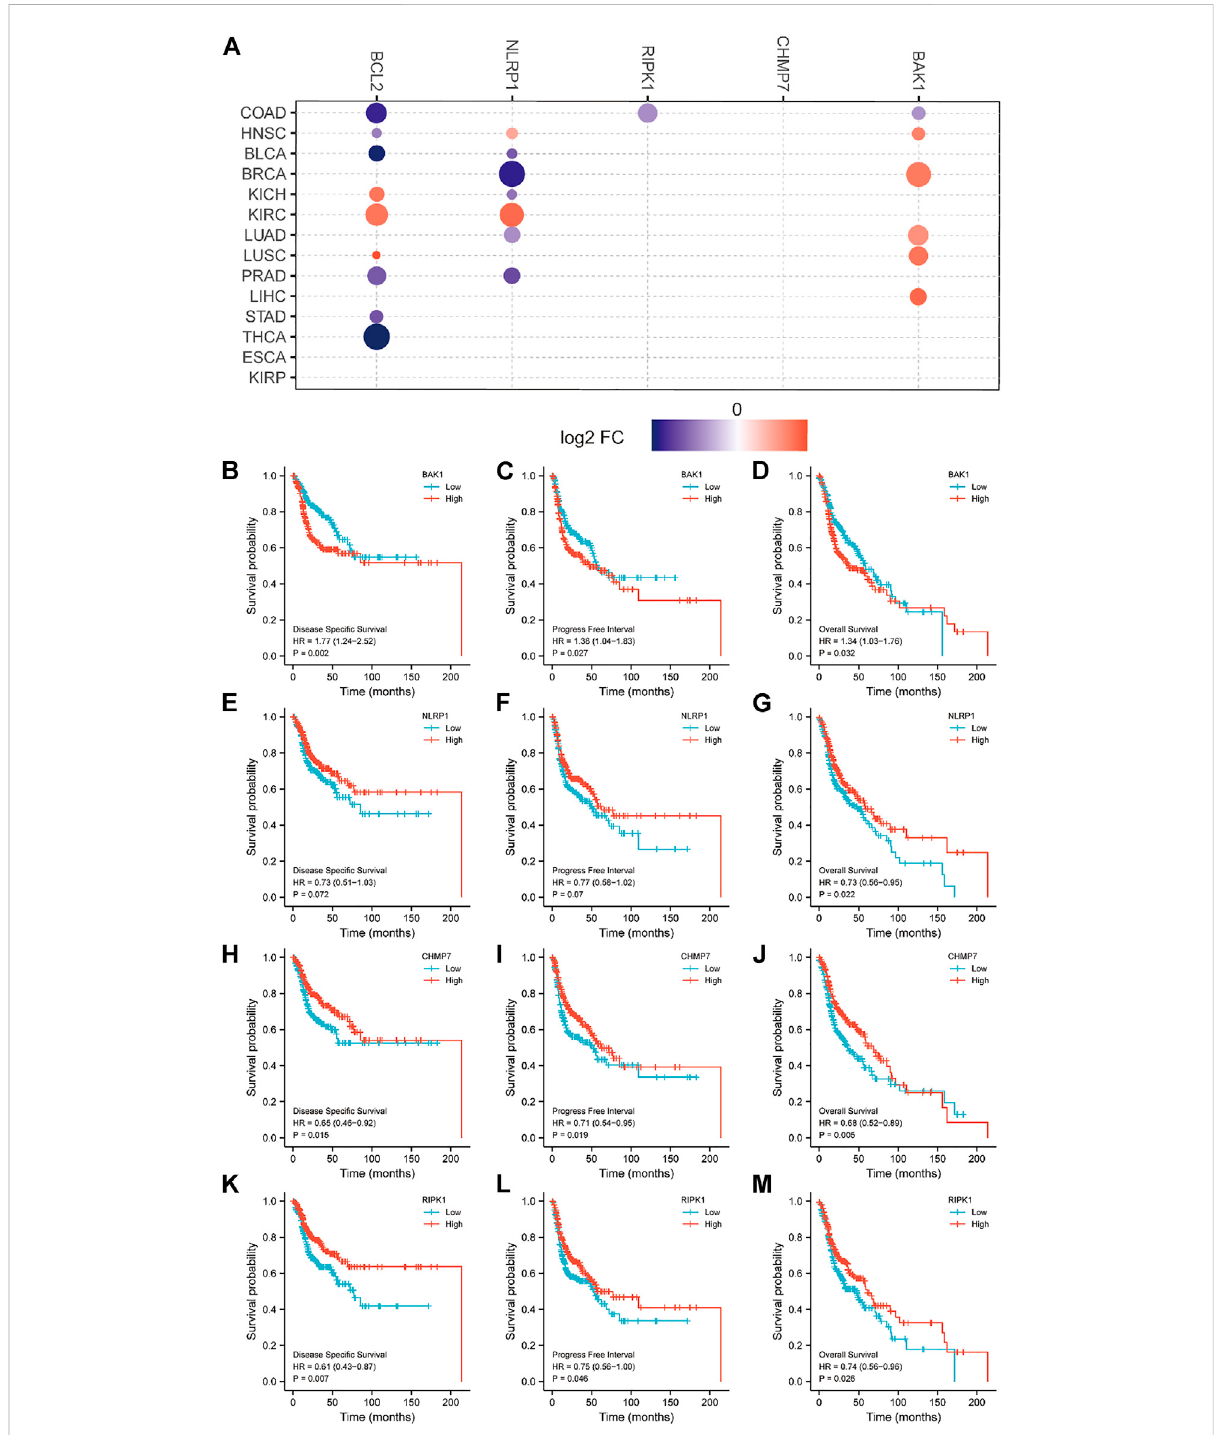
FIGURE 7 Relationship between BAK1, NLRP1, CHMP7, and RIPK1 messenger RNAs (mRNAs) and prognosis of head and neck squamous cell carcinoma (HNSCC) patients. (A) Relationship between BAK1, NLRP1, CHMP7, and RIPK1, Bcl-2 mRNAs expression and tumor survival in the Cancer Genome Atlas database; Kaplan-Meier (K-M) plotter showing survival curves for disease free survival (DFS); (B) Progression-free interval (PFI); (C) Overall survival(OS); (D) ForBAK1andHNSCC;theK-MplottershowsDFSforNLRP1andHNSCC; (E) PFI; (F) OS; (G) Survivalplots;K-Mplottershowing DFS; (H) PFI; (I) OS; (J) Survival plots for CHMP7 and HNSCC; K-M plotter showing DFS; (K) PFI; (L) OS; (M) Survival plots for RIPK1 and